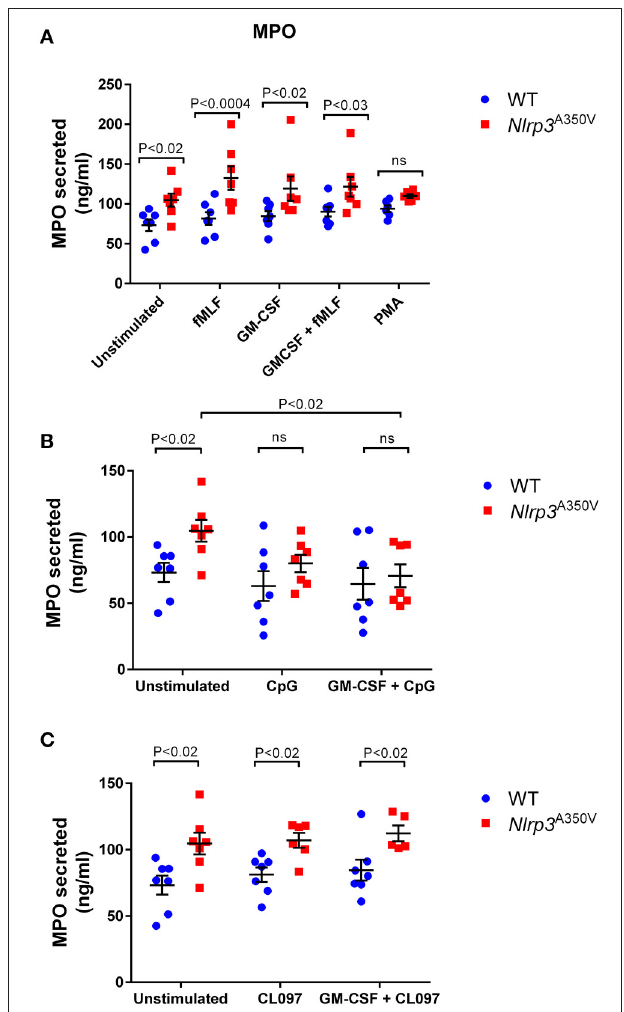
FIGURE 3 | Effect of the Nlrp3 A350V mutation on azurophilic granule exocytosis in neutrophils. The mobilization of azurophilic granules was analyzed by monitoring the secretion of myeloperoxidase (MPO) by ELISA as described under “Materials and Methods.” (A–C) Wild type (WT; blue) or MWS neutrophils (Nlrp3 mutant; red) were treated with GM-CSF or vehicle for 30min and subsequently stimulated with the indicated agonists as described under “Materials and Methods.” Each symbol corresponds to an individual mouse and the error bars indicate mean ± SEM of 7 independent mice from 3 independent experiments. Significant differences between groups were calculated using ANOVA followed by Fisher’s post-hoc test. ns, not